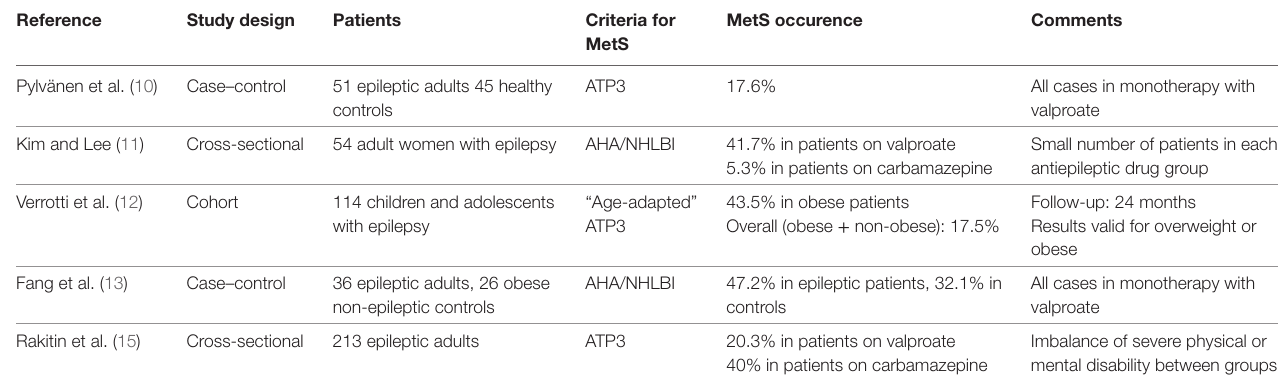
TaBle 1 | Summary of published studies evaluating metabolic syndrome (MetS) occurrence in epilepsy